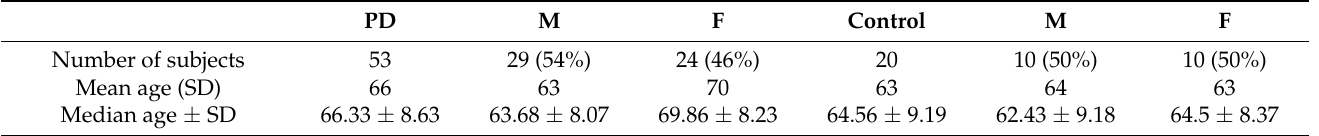
Table 1. Demographic description of the study